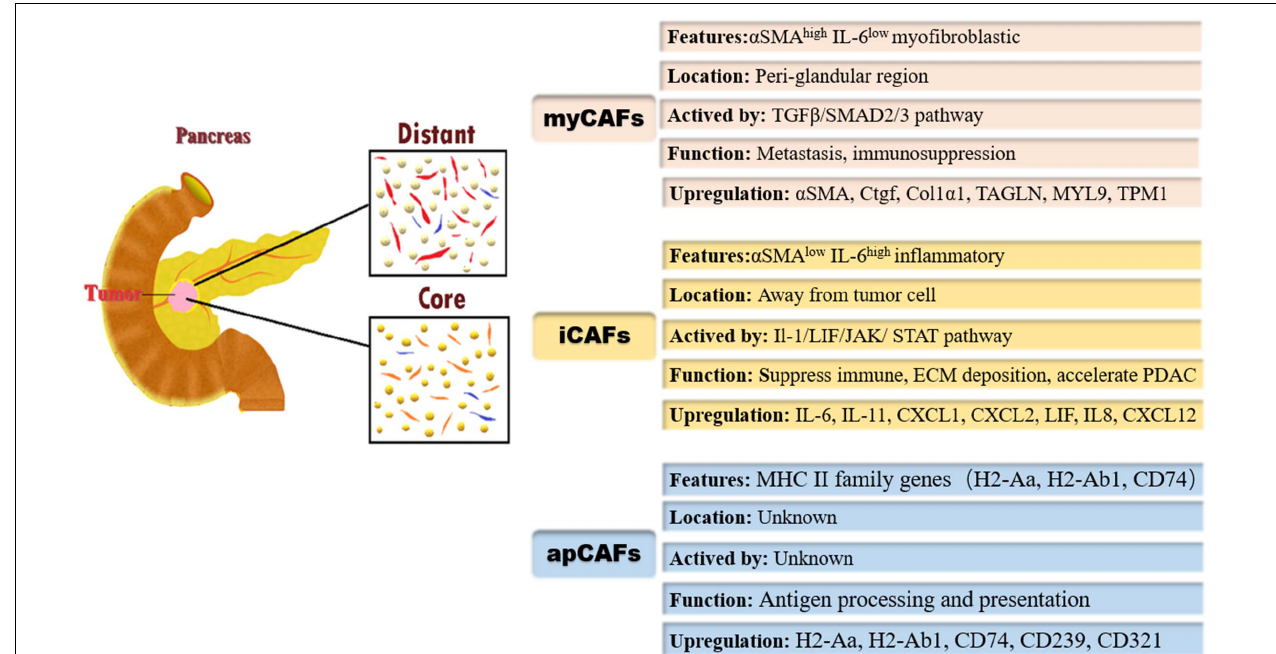
FIGURE 1 | Heterogeneity of cancer-associated fibroblasts (CAFs) and their markers/pathways; the different subpopulations of CAFs are geographically segregated in PDAC tumor microenvironment. myCAFs, myofibroblastic cancer-associated fibroblasts; α SMA, α -smooth muscle actin; IL-6, interleukin-6; TGF- β , transforming growth factor- β ; SMAD, Drosophila mothers against decapentaplegic protein; Ctgf, connective tissue growth factor; Col1 α 1, collagen type I alpha 1; TAGLN, transgelin; MYL9, myosin regulatory light chain 9; TPM1, tropomyosin 1; iCAFs, inflammatory cancer-associated fibroblasts; JAK, Janus kinase; STAT, signal transducer and activator of transcription; CXCL1, chemokine (C-X-C motif) 1; apCAFs, antigen-presenting cancer-associated fibroblasts; MHC II, major histocompatibility complex II; H2-Aa, encoding α -chains of MHC II; H2-Ab1, encoding β -chains of MHC II.